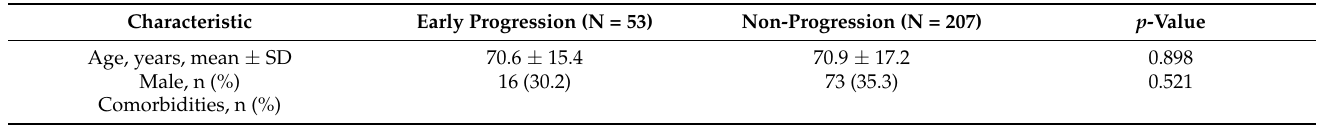
Table 1. Characteristics of patients with community-acquired pneumonia between those with early progression to severe pneumonia and those with non-progression within 72